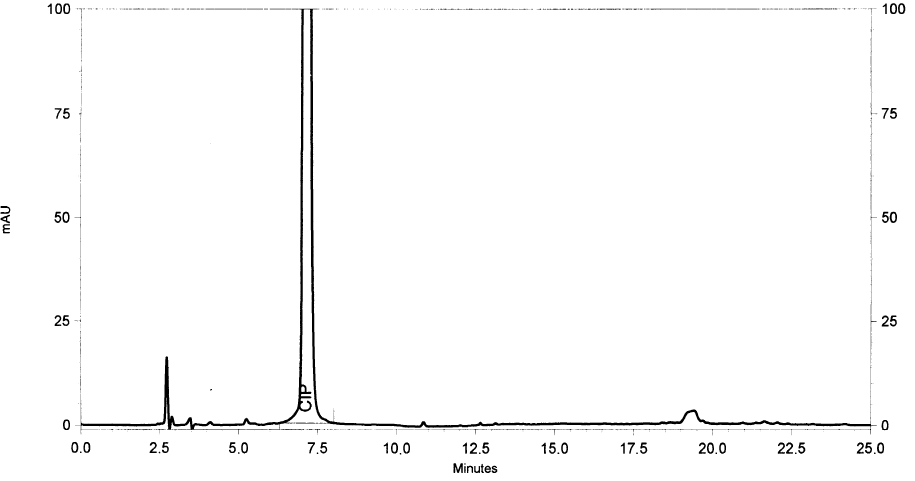
Figure 9. Chromatogram of the CIP oxidized by H 2 O 2 after incubation for 56 days at room temperature.